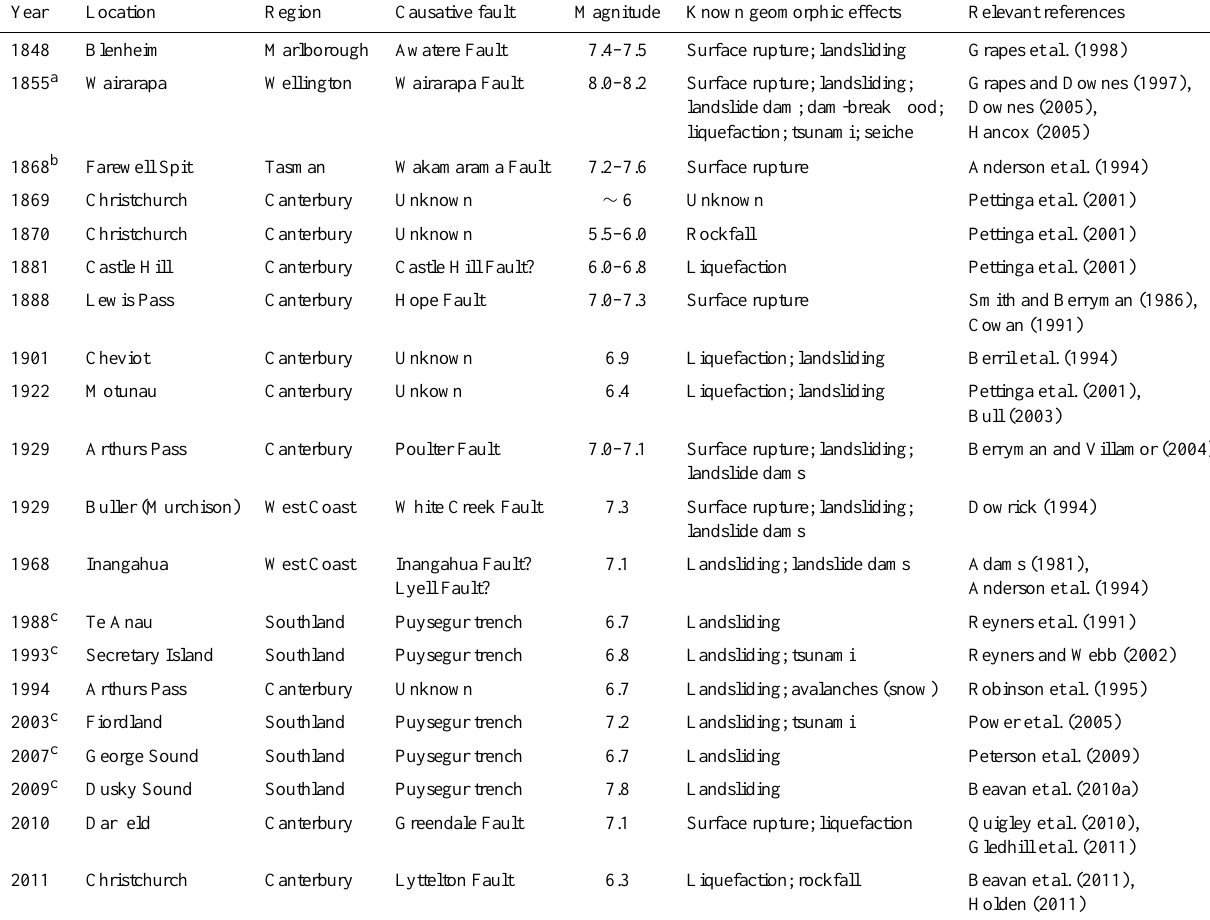
Table 1. Significant earthquakes and their geomorphic effects for the South Island region, New Zealand, since European colonisation. Year